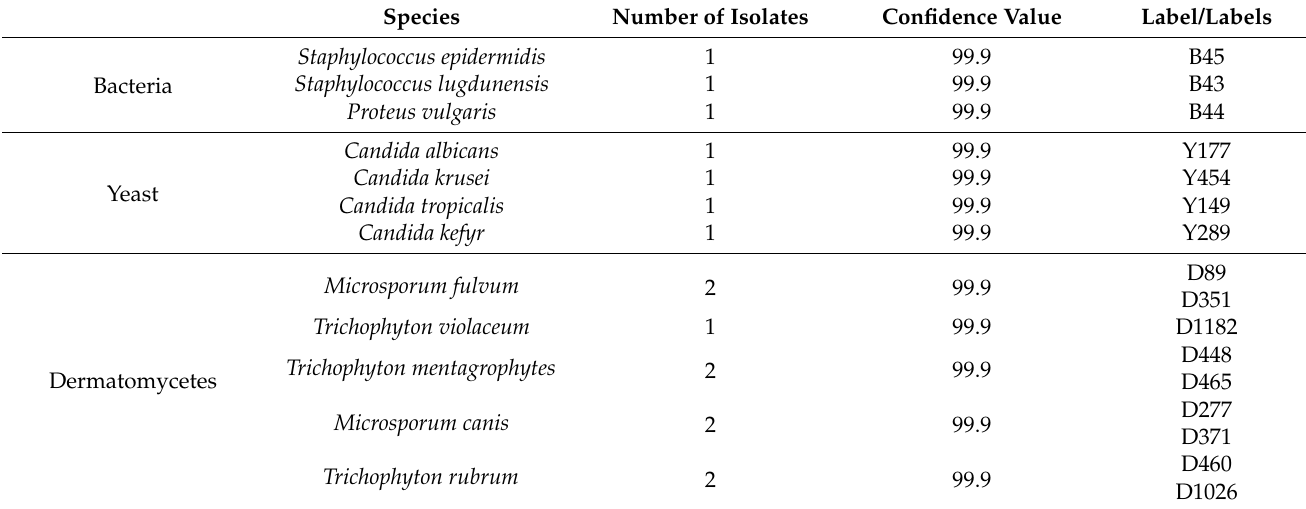
Table 3. Pathogenic isolates from human skin and/or corneal formations identified by MALDI- TOF/MS. Species Number of Isolates Confidence Value